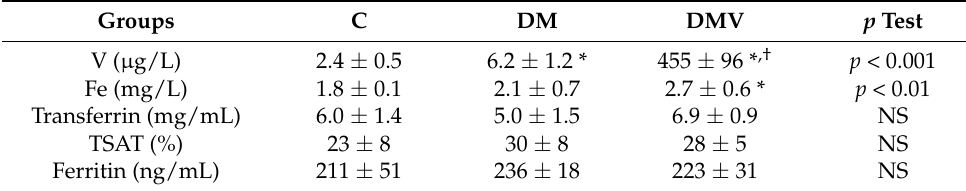
Table 3. Serum level of V, Fe, transferrin, ferritin, TSAT on day 35. Groups